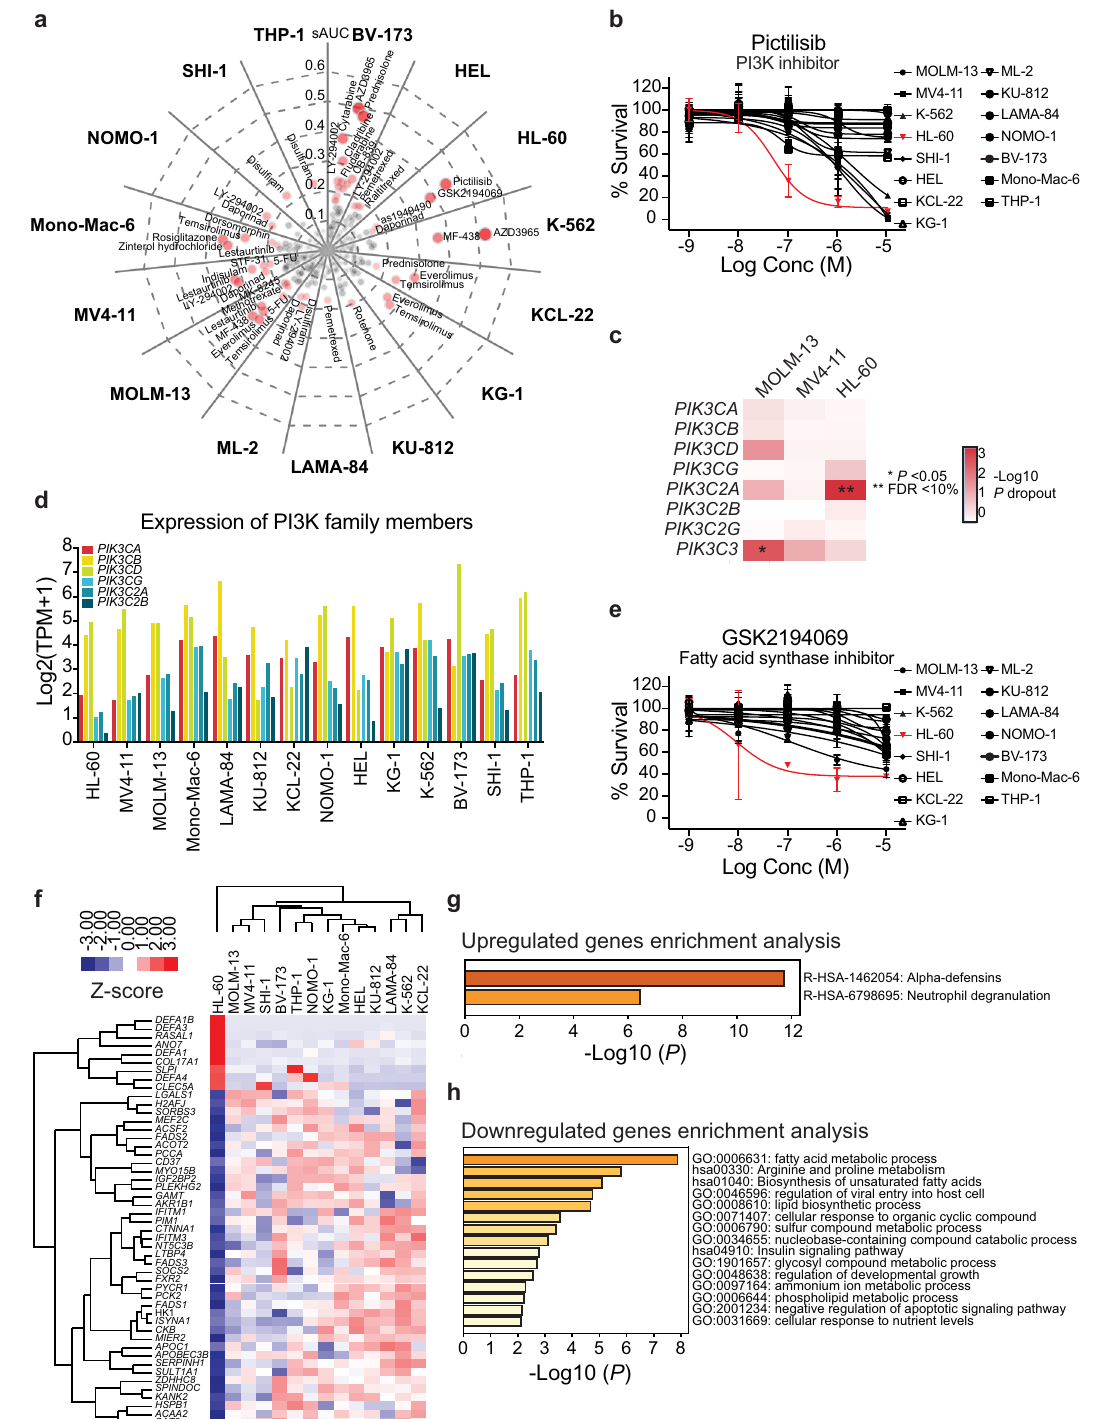
metabolismGO:0006631: fatty acid metabolic acidshsa00330: Arginine and proline cellhsa01040: Biosynthesis of unsaturated fatty GO:0046596: regulation of viral entry into host compoundGO:0008610: lipid biosynthetic process processGO:0071407: cellular response to organic cyclic processGO:0006790: sulfur compound metabolic pathwayGO:0034655: nucleobase-containing compound catabolic processhsa04910: Insulin signaling growthGO:1901657: glycosyl compound metabolic processGO:0048638: regulation of developmental processGO:0097164: ammonium ion metabolic pathwayGO:0006644: phospholipid metabolic levelsGO:2001234: negative regulation of apoptotic signaling GO:0031669: cellular response to nutrient